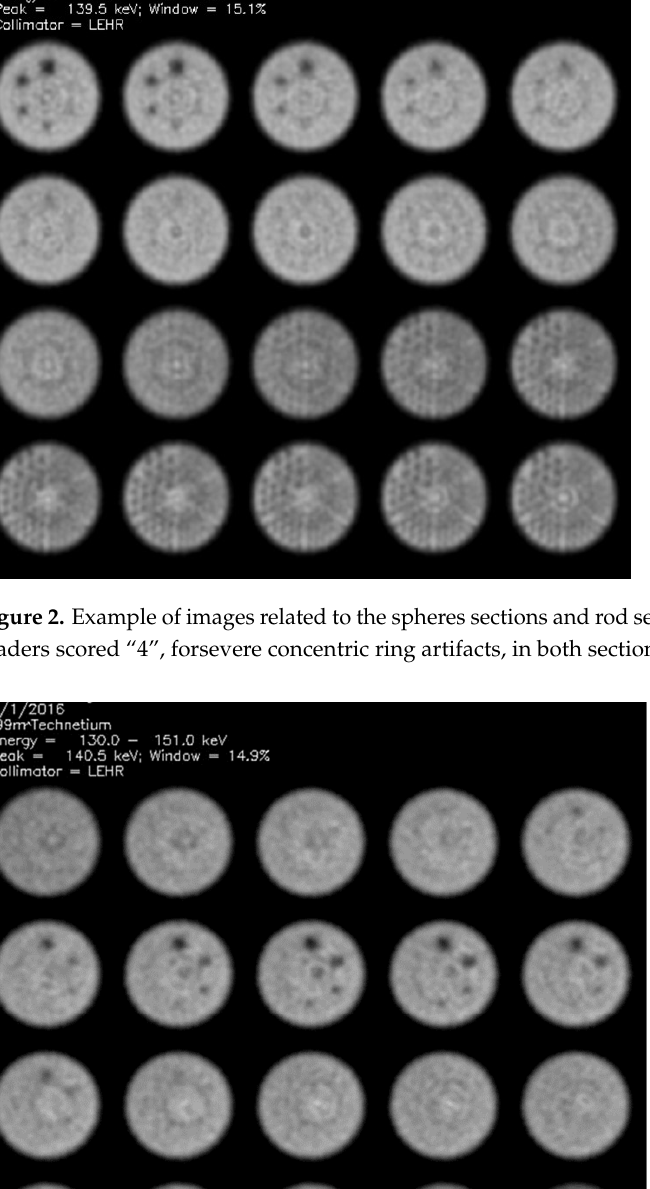
Figure 4. Example of images related to the uniform sections and spheres sections of a phantom, which both readers scored “4”, forsevere concentric ring artifacts, in both sections. One physicist (KJN) re ‐ scored the images blinded to his initial scores and to those of the other reader, to enable the assessment of intra ‐ rater reproducibility. Readers had no knowledge of any texture analysis metrics values; these values were not computed until after all readings were completed by both readers. To compute cut ‐ off values for the presence of ring artifacts, scale ratings were di ‐ chotomized so that any reading >2 was assigned 1 and any reading <2 to 0. Ambiguous readingsequal to 2 were excluded from this analysis.